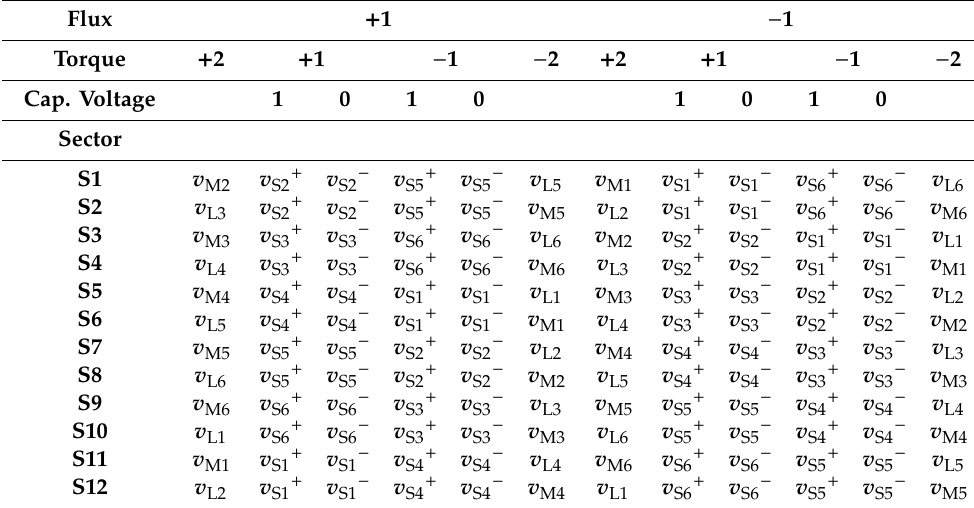
Table 1. Look-up Table for